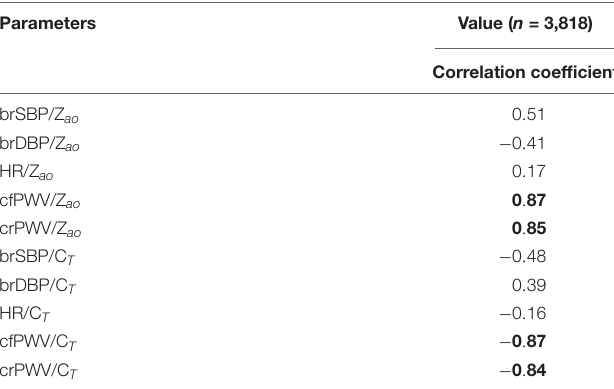
TABLE 3 | Correlation coefficients between the input regression features and the target